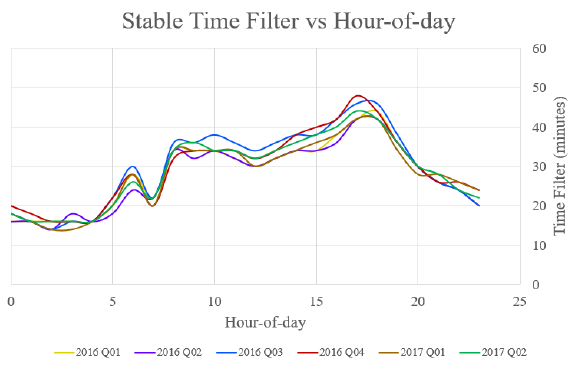
Figure 8. Stable time filter value of different hours of the